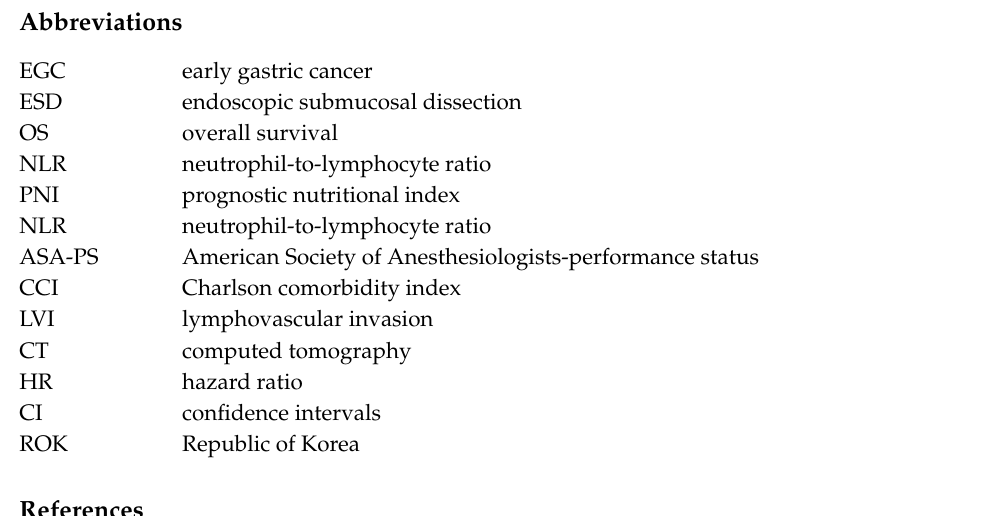
Figure S1: Kaplan–Meier estimation of overall survival (OS) for each group. The 3-, 5-, and 10-year OS rates in the curative resection group were 91.0%, 86.9%, and 58.3%, respectively and those in the non-curative resection group were 91.6%, 72.7%, and 43.8%, respectively. ESD, endoscopic submucosal dissection; EGC, early gastric cancer. Figure S2: Kaplan–Meier estimation of overall survival (OS) for each group. The 3-, 5-, and 10-year OS rates in the low-risk group were 94.6%, 90.1%, and 63.8%, respectively and those in the high-risk group were 80.0%, 62.5%, and 22.1%, respectively. ESD, endoscopic submucosal dissection; EGC, early gastric cancer. Table S1: Details of patients who died because of gastric cancer after